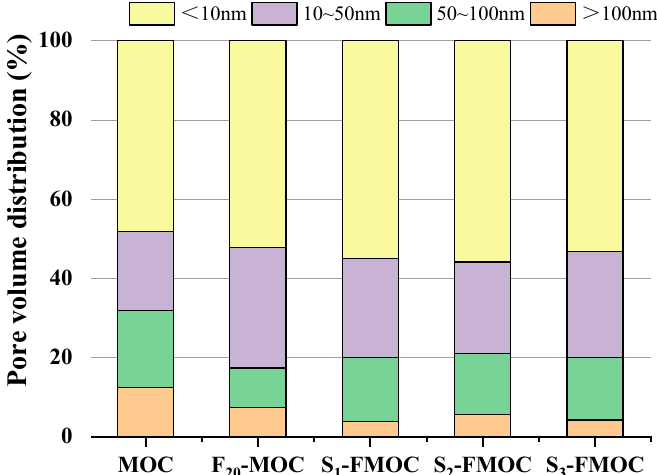
Figure 16. Pore volume distribution of hardened multi-doped MOC.